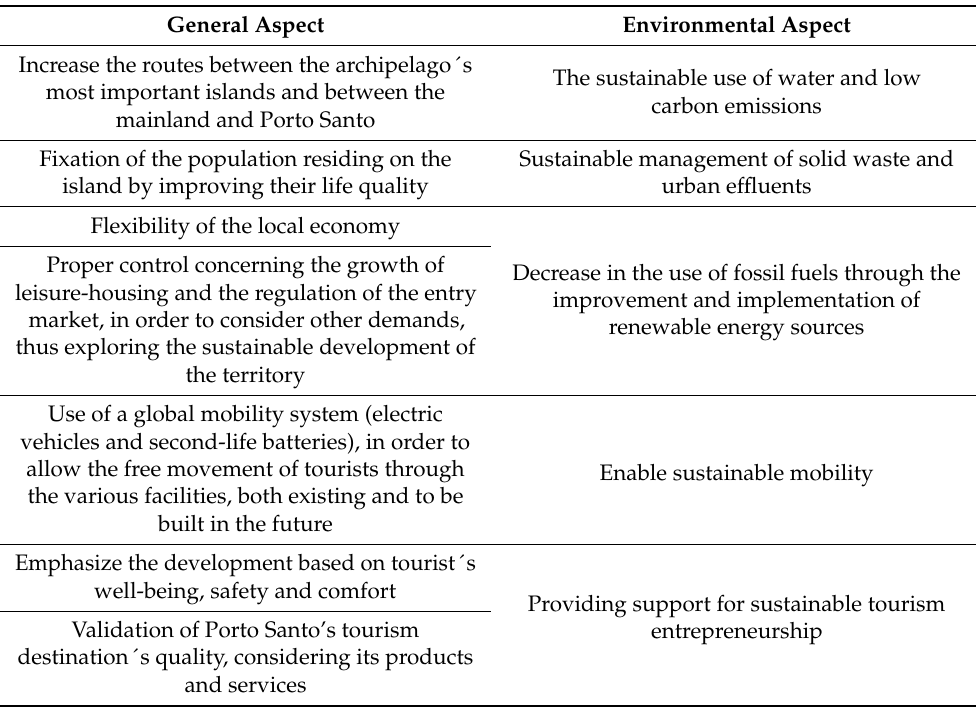
Table 3. Optimization of the tourism model—Topics.